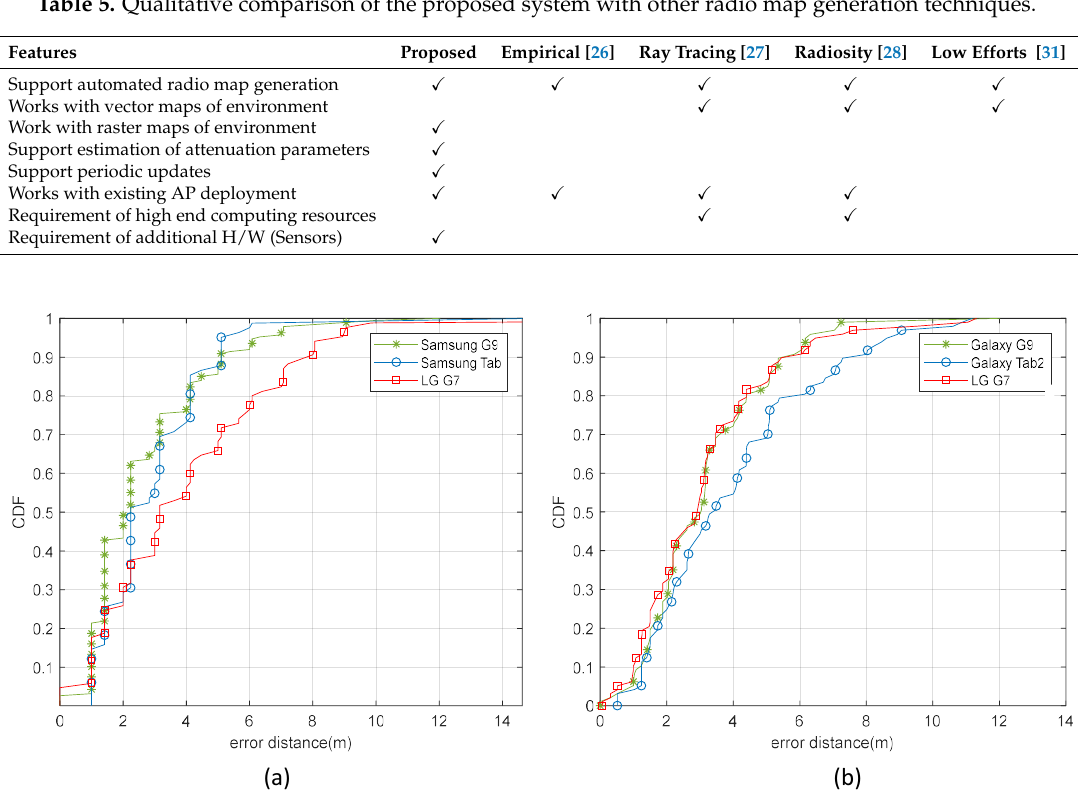
Figure 15. The probability of distance error in positioning for proposed system using different mobile devices at both sites. ( a ) The ICE department. ( b ) The CS